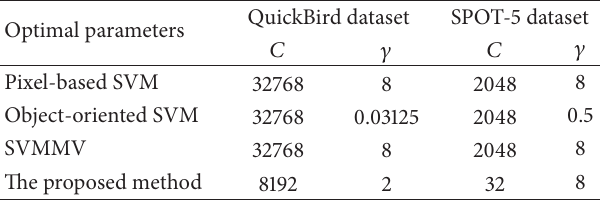
Table 1: Optimal parameters of all SVM classification experiments. QuickBird dataset SPOT-5 Optimal parameters